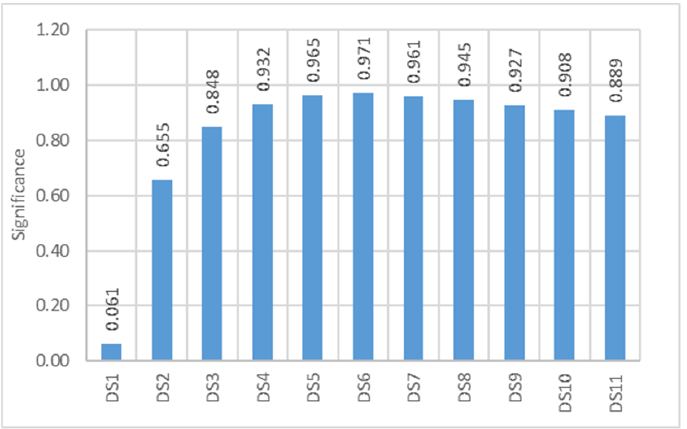
Figure 11. Significance of design solutions.